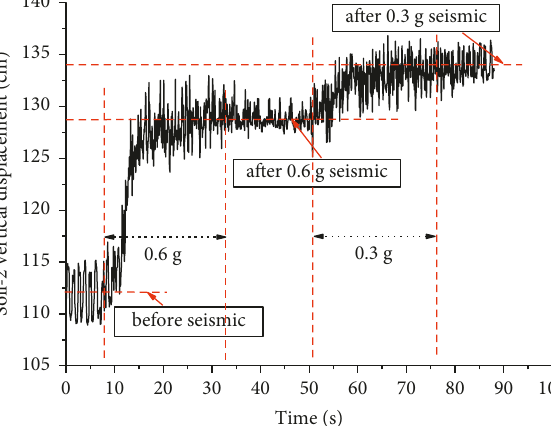
Figure 7: Time histories of vertical displacement of soil-2 in the